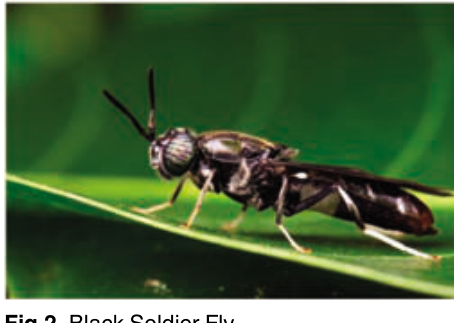
Fig 1. Modified bin with food waste Fig 2. Black Soldier Fly